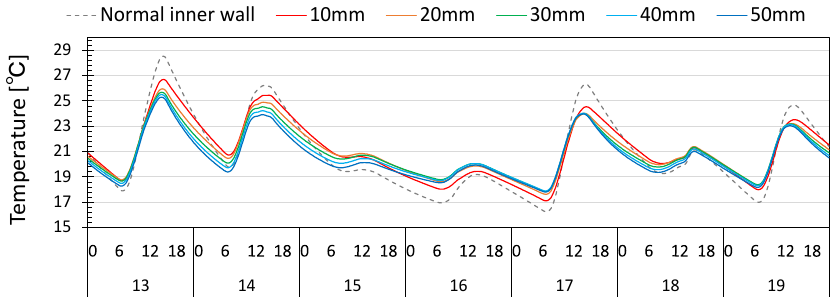
Figure 12. Influence of heat-storage wall thickness on room temperature (February).